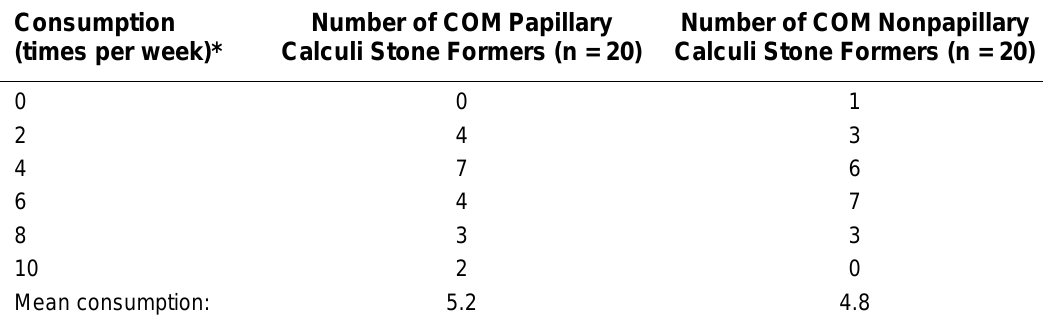
Dietetic Habits Study: Consumption of Phytate-Rich Food (Legumes, Nuts, Dietetic Fiber, Wholemeal Breads and Other Wholegrain